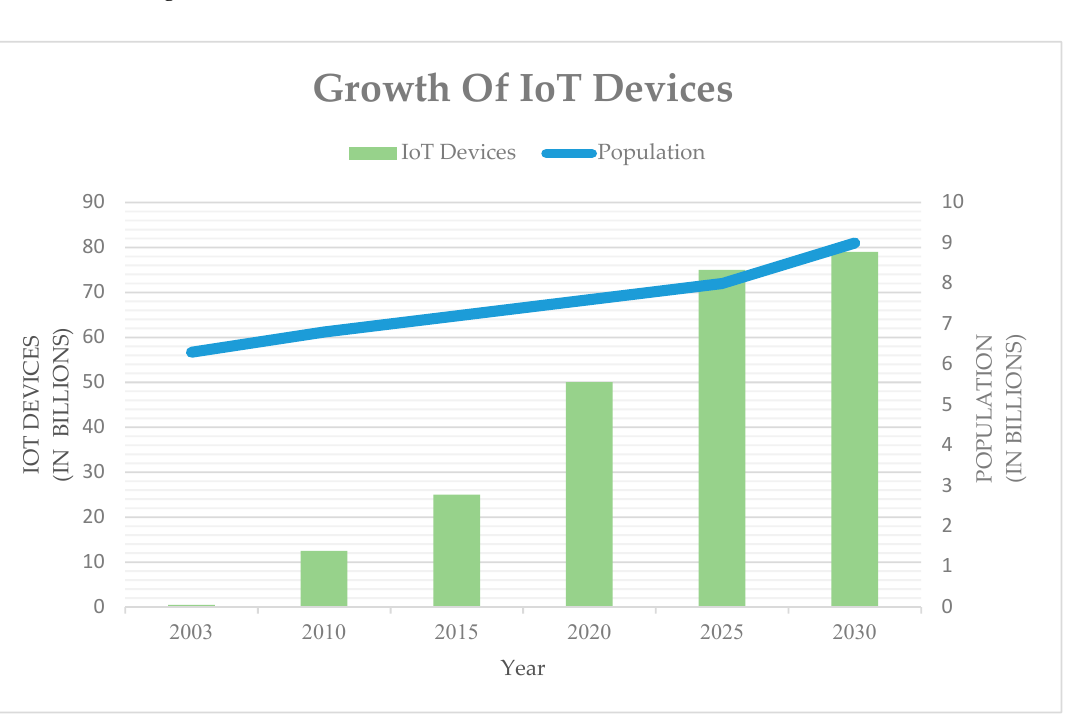
Figure 1. Growth of Internet of Things (IoT) Devices with Population [6].